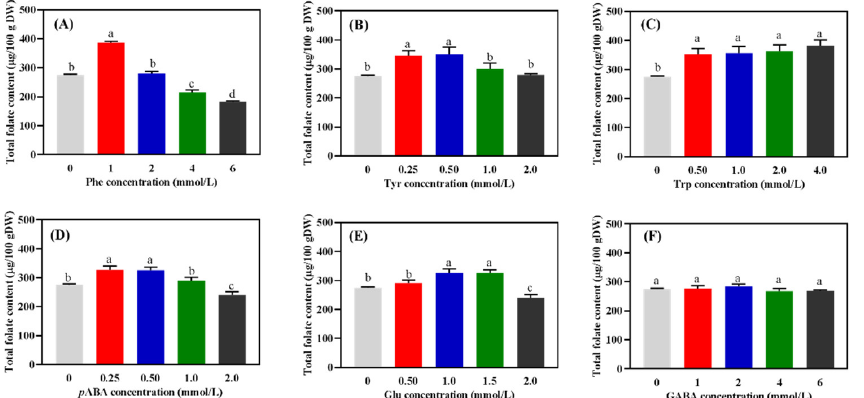
Figure 1. The content of total folates in wheat seedlings with different treatments ( n = 3). Phe ( A ), Tyr ( B ), Trp ( C ), p ABA ( D ), Glu ( E ), and GABA ( F ) were seedlings treated with phenylalanine, tyrosine, tryptophan, p -aminobenzoic acid, γ -aminobutyric acid, and glutamate, respectively. a–d represent significant differences among different treatment concentrations ( p <